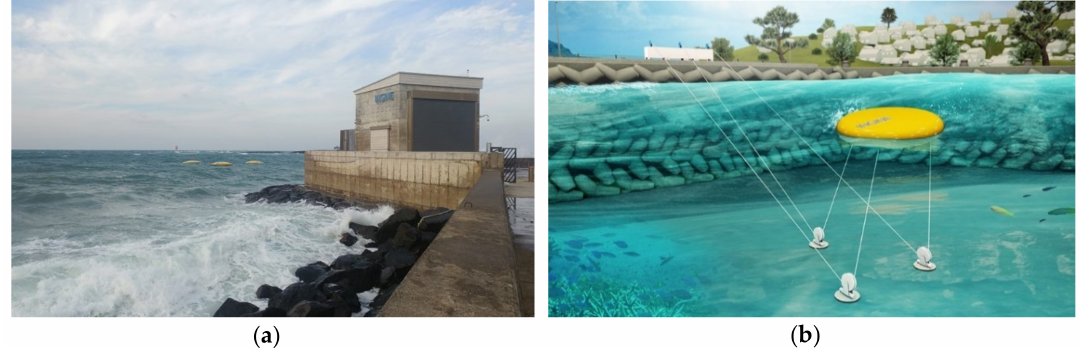
Figure 7. INGINE wave energy harvesting station. ( a ) Scene from the experimental site located at Bukchon in Jejudo. ( b ) Simulated arrangement of the connecting ropes of the